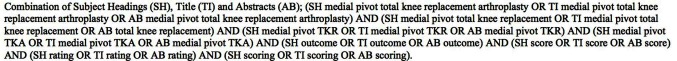
 Search Strategy for Published Peer Reviewed Articles (OVID Medline, Cochrane Database of Systematic Reviews, and PubMed).